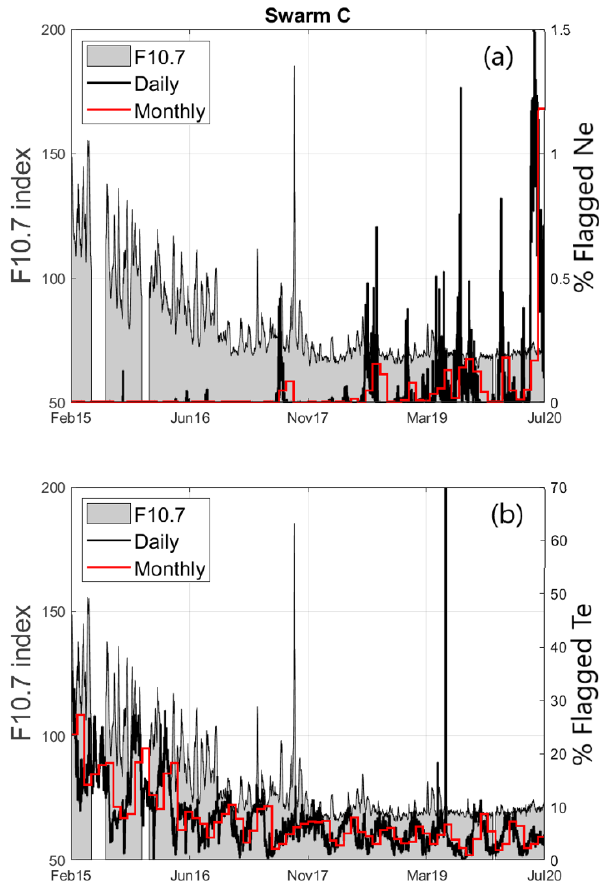
Figure 7. Daily (black lines) and monthly (red lines) percentage of invalid measurements (right axis) of (a) plasma density and (b) elec- tron temperature measured by Swarm C from February 2015 to July 2020. The grey area in the panels represents the F10.7 index (left axis) in solar flux units in the same interval of time. Table 4. Percentage of T e extreme values ( T e > 20000K) observed during 2019 at different latitudinal